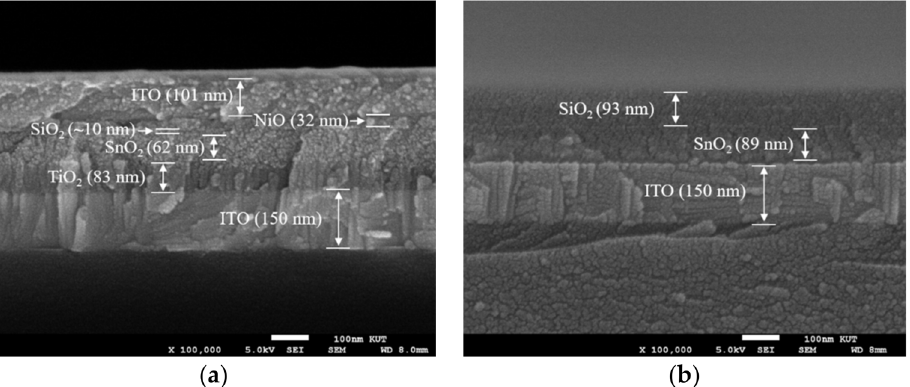
Figure 10. SEM image of ( a ) the EC device with 2 wt% Sn-doped NiO layer and ( b ) SnO 2 layer on which the separated SiO 2 layer is formed after UV